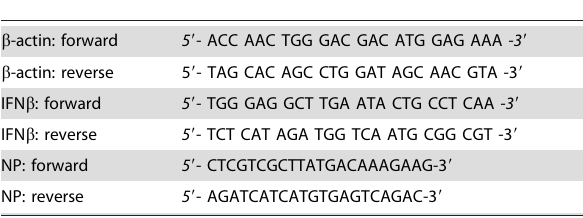
Table 3. Sequences of primers used for real-time